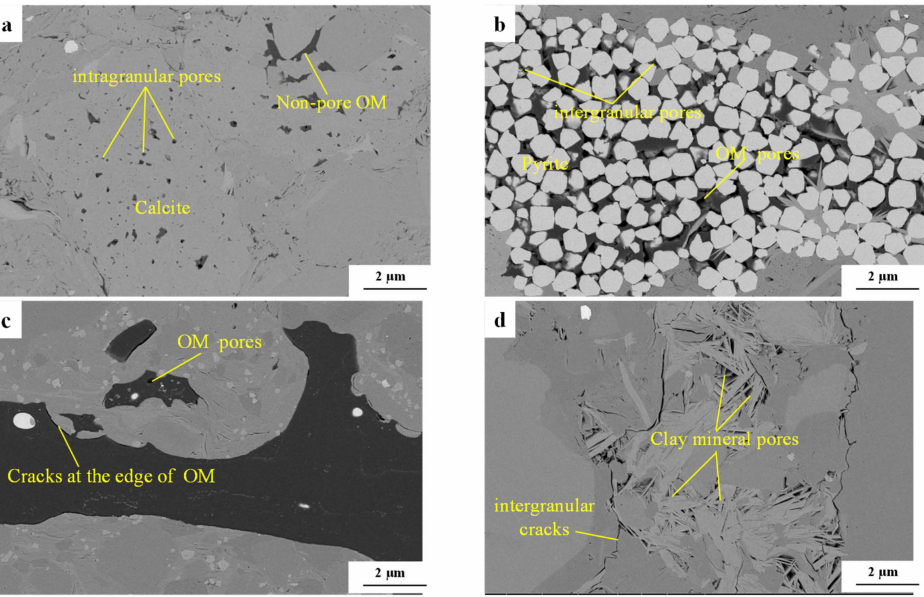
Figure 3. SEM images showing the characteristics of pores in the Funing Formation. ( a ) Intragranular pores, F10; ( b ) intergranular pores between pyrite, F1; ( c ) organic pores, F5; ( d ) clay mineral pores,